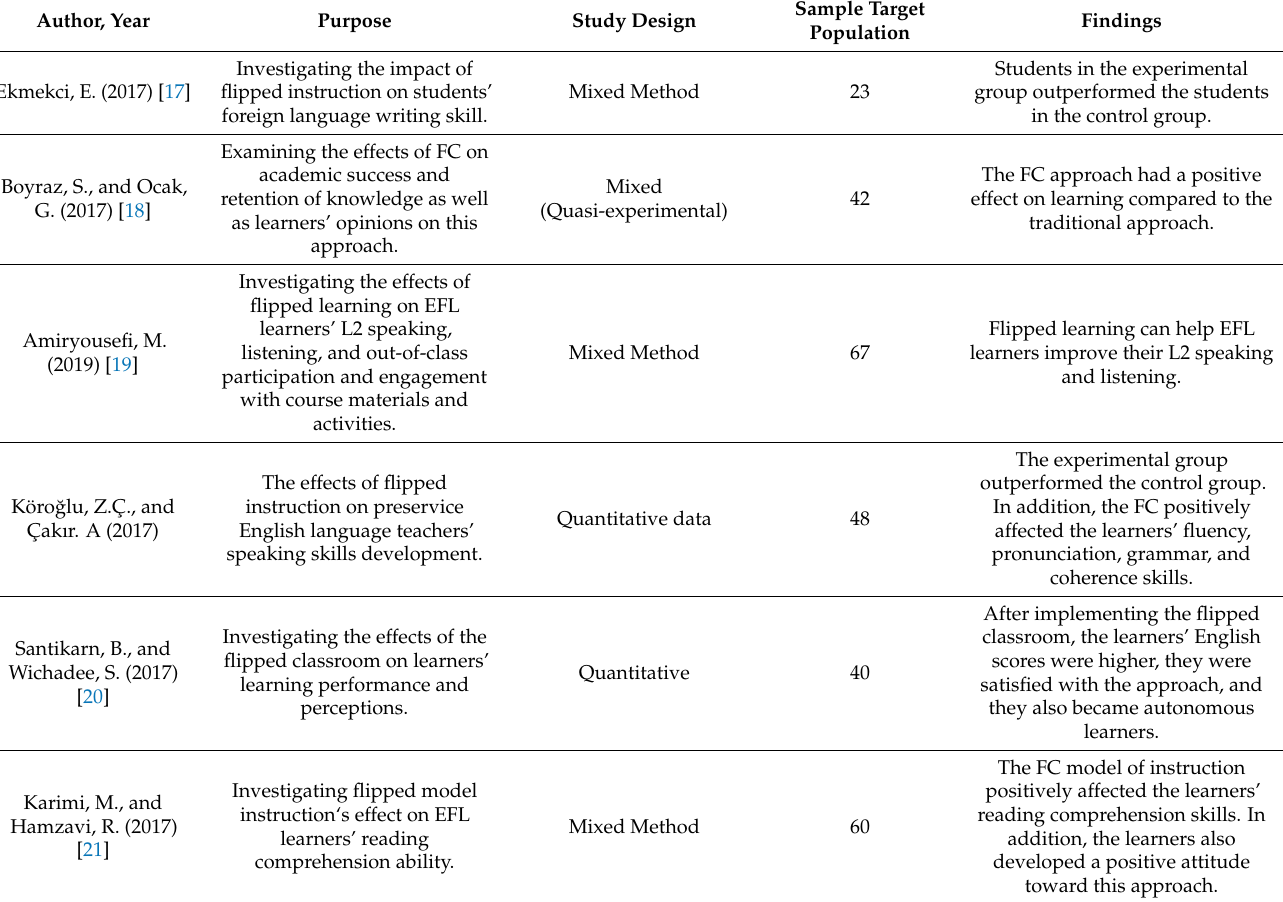
Table 1. Research papers published before COVID ‐ 19.